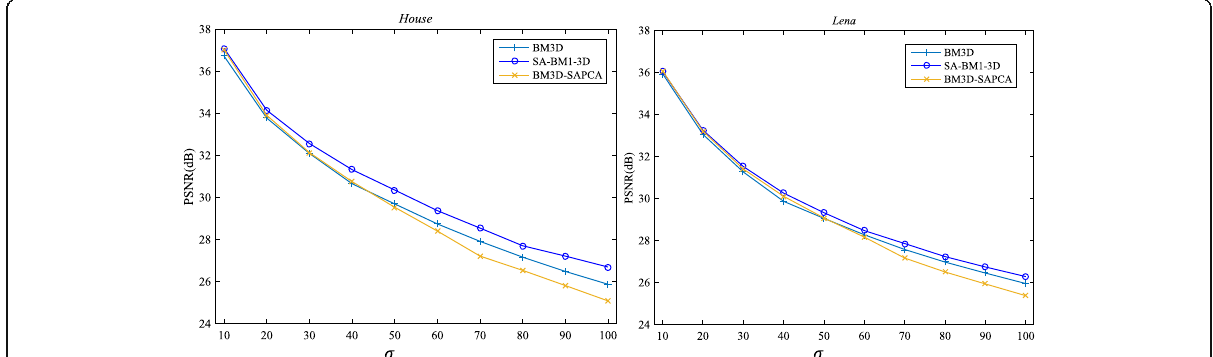
Fig. 10 The denoised PSNR values comparison among BM3D, BM3D-SAPCA, and SA-BM1-3D for gray Lena and House